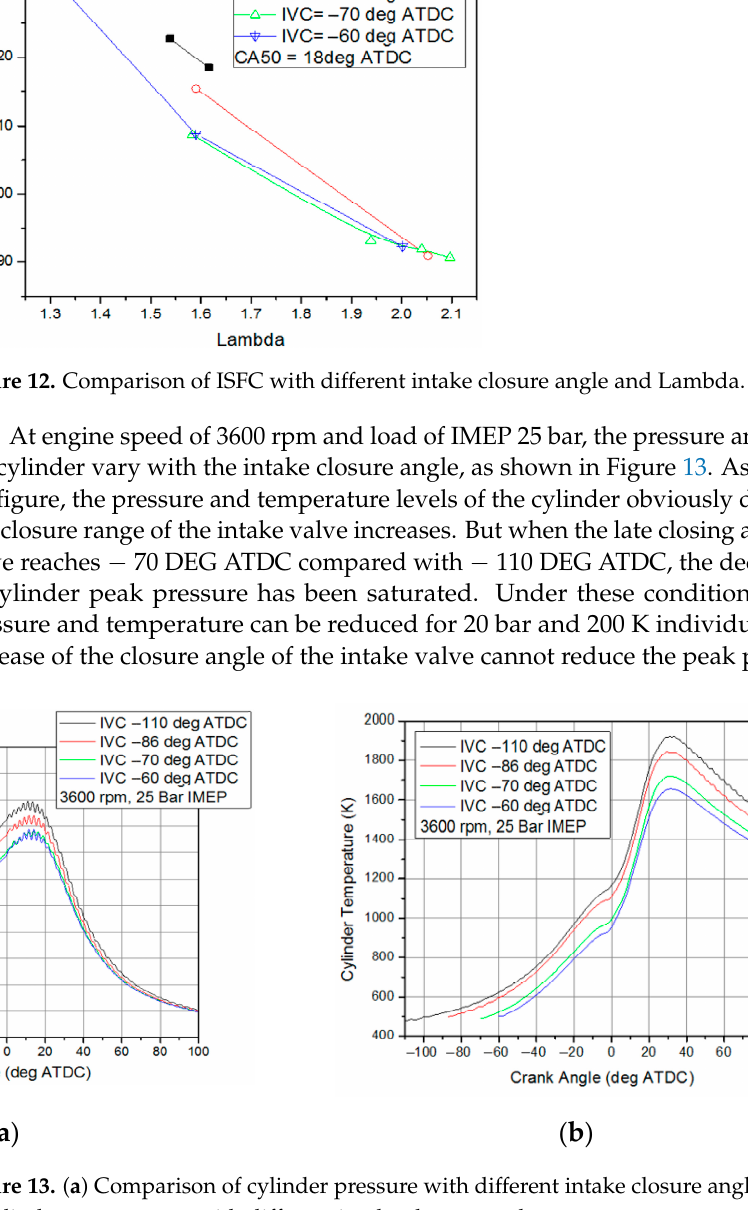
Figure 13. ( a ) Comparison of cylinder pressure with different intake closure angles; ( b ) Comparison of cylinder temperature with different intake closure angles.